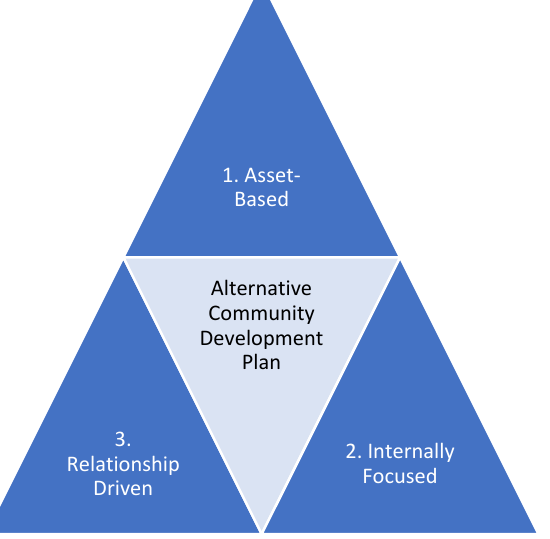
Figure 3. Three basic principles of an alternative community development plan. Source: Authors.